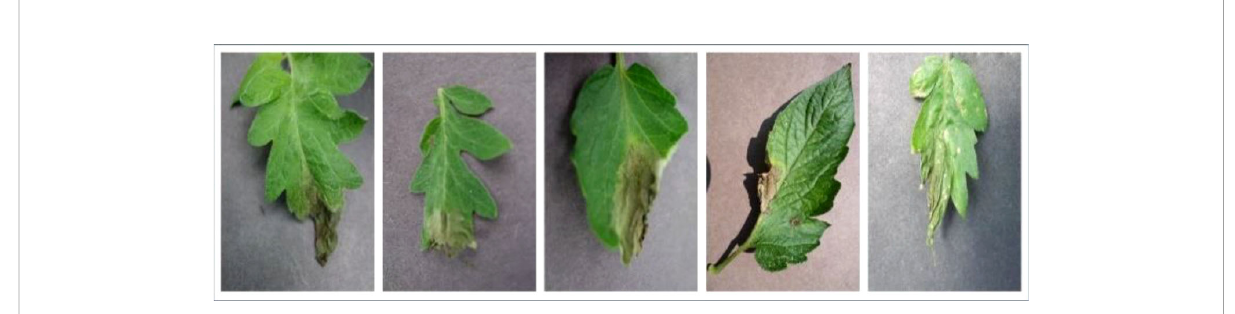
FIGURE 1 Some enhanced images using the AIM, NST, and GAN